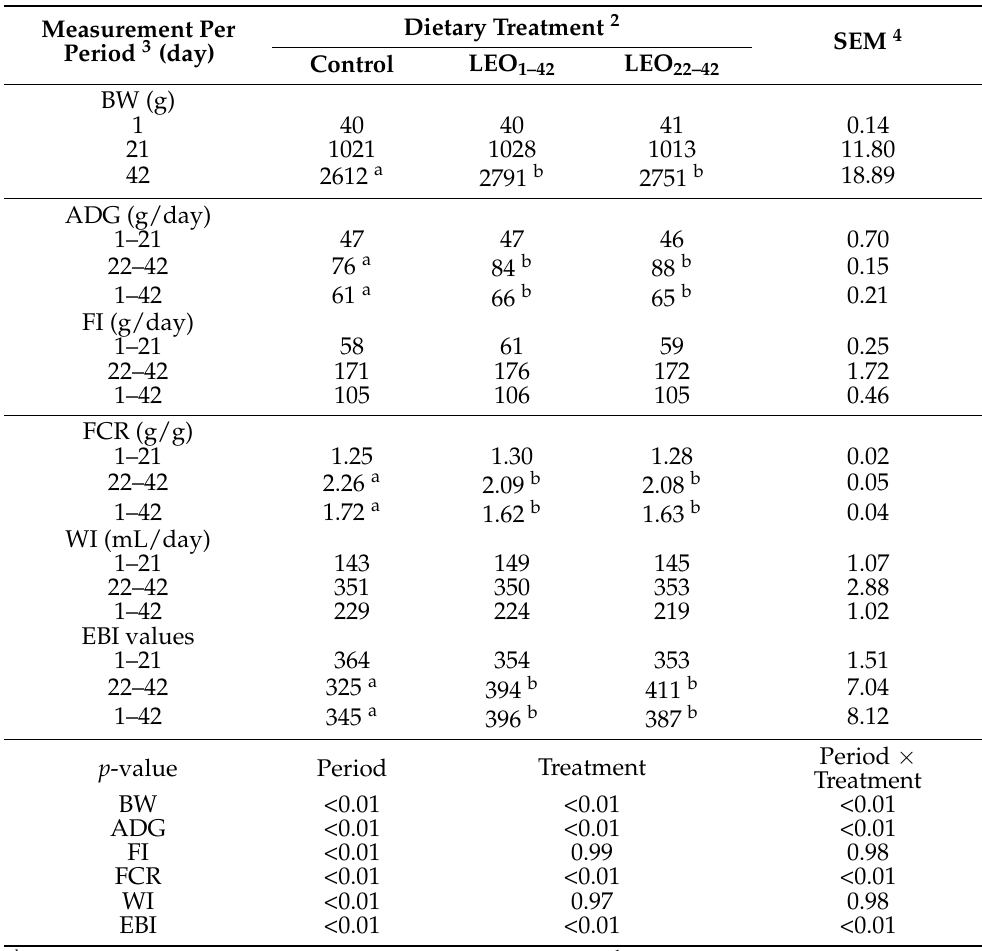
Table 2. The effect of LEO on the performance parameters of broiler chickens from 1 to 42 days of age 1 . Measurement Per Period 3